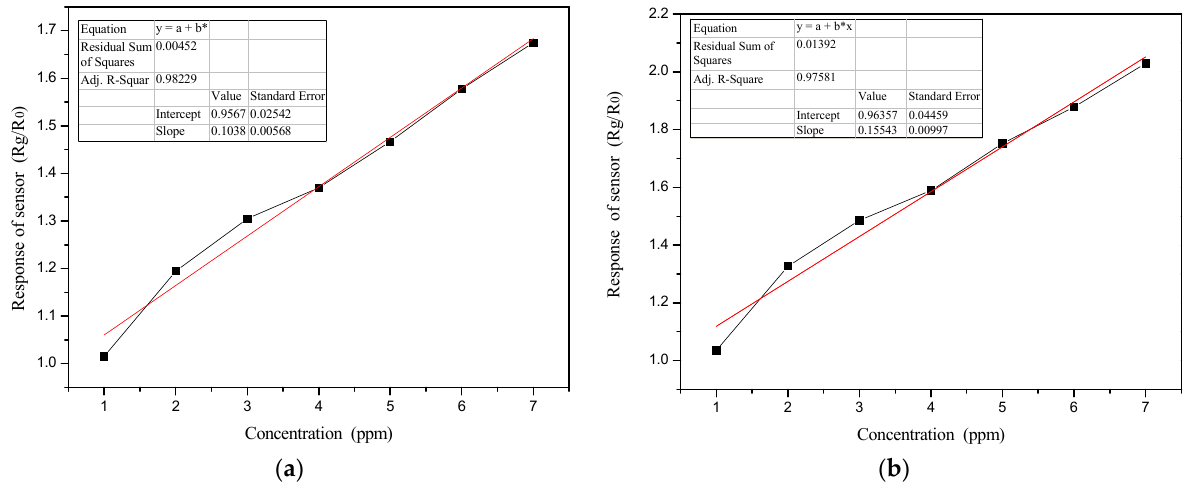
Figure 10. Gas sensor response curves with ammonia concentration. ( a ) PANI; ( b ) PANI/SnO 2 . The asterisk (*) represents a multiplier (x).